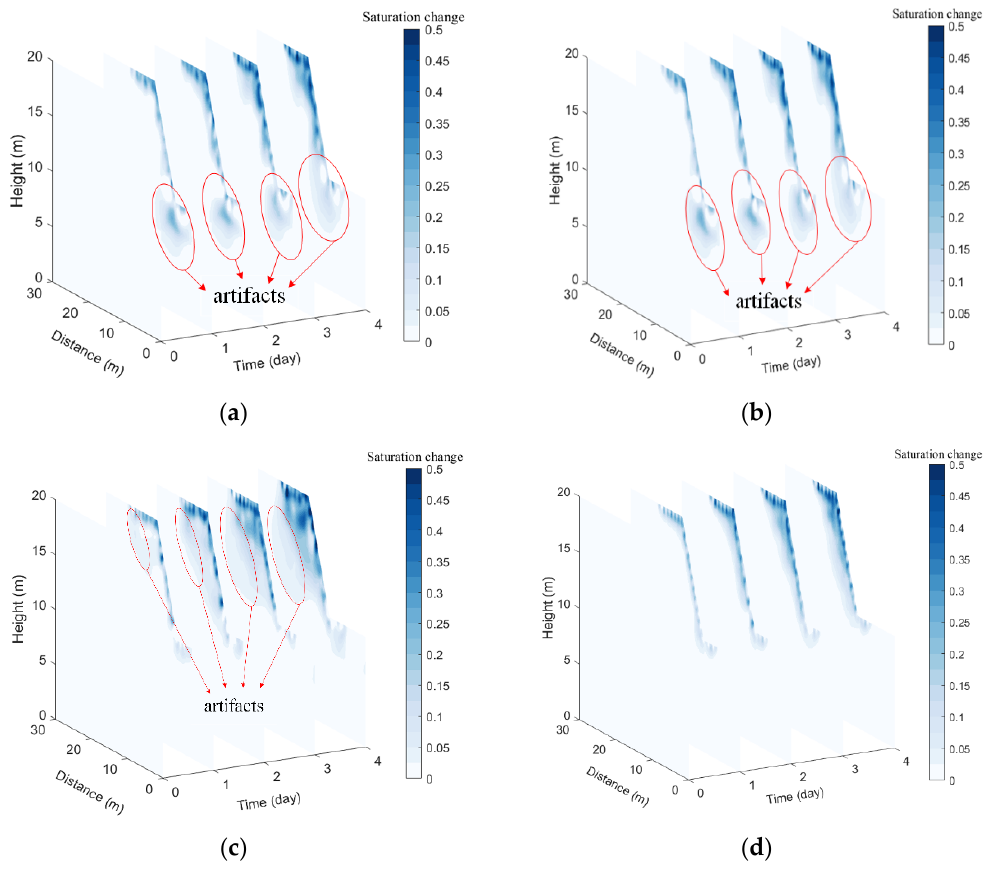
Figure 7. The spatial and temporal evolution of saturation obtained by inversion under the condition of 3% Gaussian noise of various arrays: ( a ) Pole-Pole array; ( b ) Pole-Dipole array; ( c ) Wenner array; ( d ) Dipole-Dipole array. Table 4. The FOS obtained by the proposed framework in the 3% Gaussian noise scenario of multiple